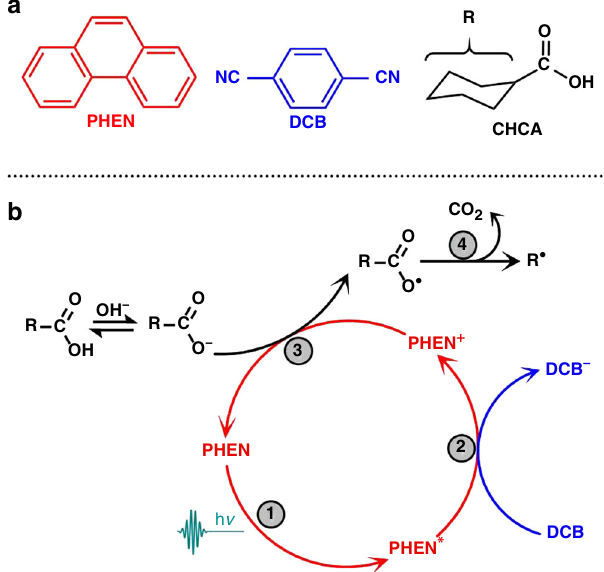
Fig. 1 A representative photocatalytic decarboxylation reaction. a Chemical structures of the molecules involved in the photochemical decarboxylation reaction — Phenanthrene (PHEN), 1,4-Dicyanobenzene (DCB) and Cyclohexanecarboxylic acid (CHCA). b Schematic diagram of a light- induced sequential decarboxylation reaction. Steps 1 through 4 denote photoexcitation, bimolecular single electron transfer from PHEN* to DCB, oxidative single electron transfer from carboxylate anion, and a C – C bond fi ssion that produces a free radical and CO 2 byproduct, respectively.